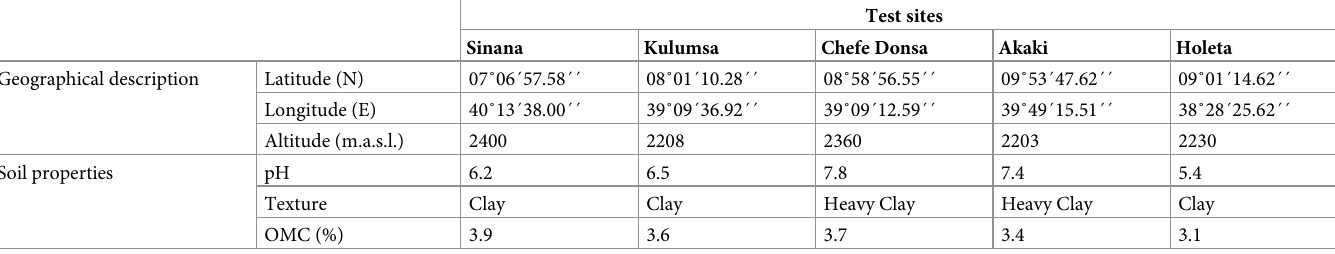
Table 1. A description of the testing